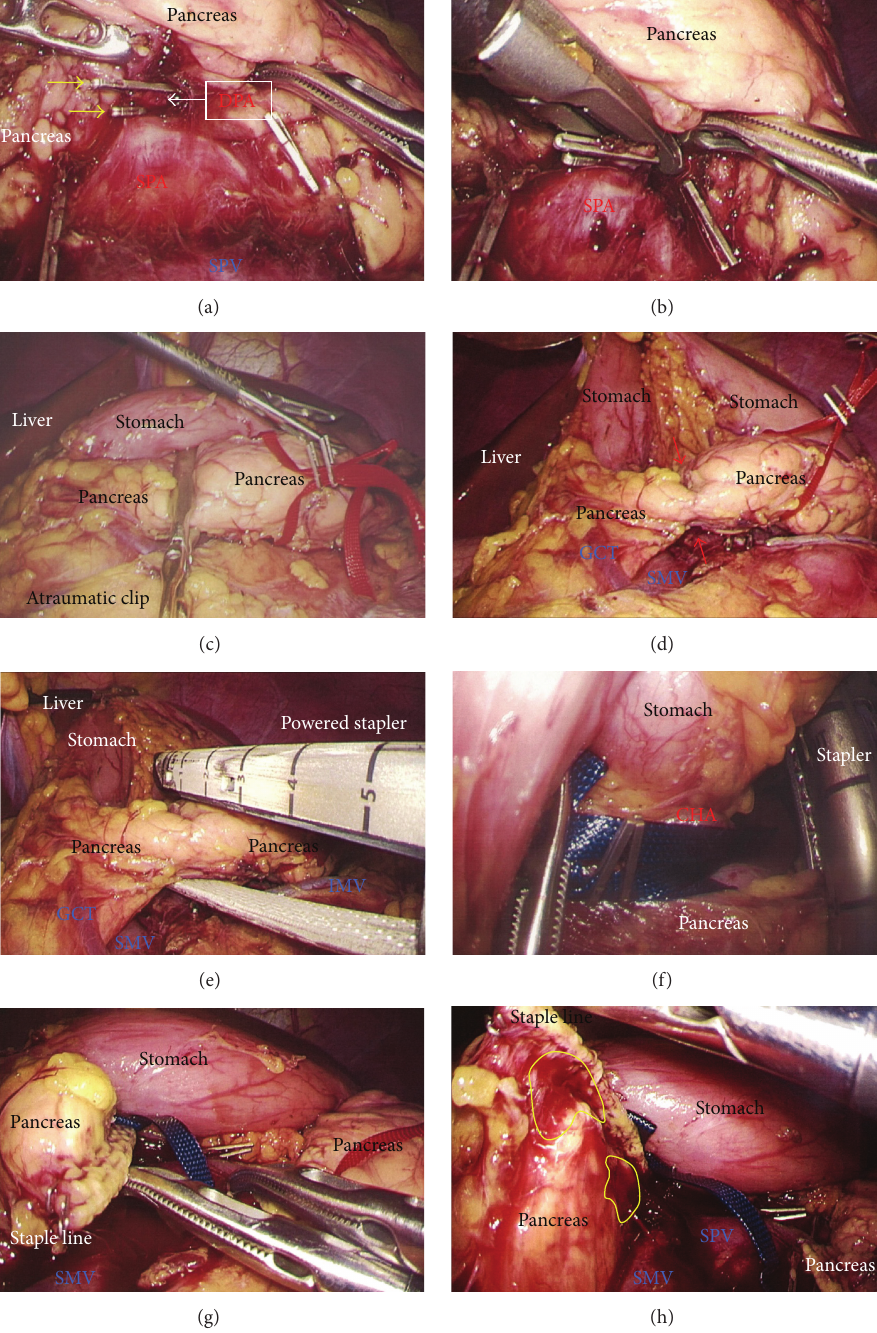
Figure 7: (a) The DPA was clipped twice with adequate margins from the SPA (yellow arrows). (b) The DPA was then cut using LCS. (c) Stapling was performed using the Covidien stapler with a separate and preceding compression step using an atraumatic clip. (d) Pancreatic parenchyma was compressed beforehand (red arrows). (e) A powered stapler was used to cut the pancreatic parenchyma. (f) Lack of involvement of vessels in the staple line was confirmed. (g) The pancreatic stump was examined. (h) The capsule of the pancreatic remnant was checked carefully and capsular injury was identified near the staple line (yellow circles). DPA, dorsal pancreatic artery; LCS, laparoscopic coagulation shears; SPA, splenic